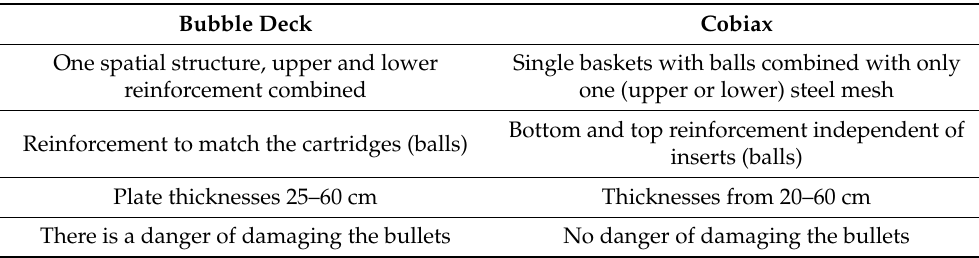
Table 1. Differences between floors with HDPE inserts [25]. Bubble Deck One spatial structure, upper and lower Single baskets with balls combined with reinforcement combined